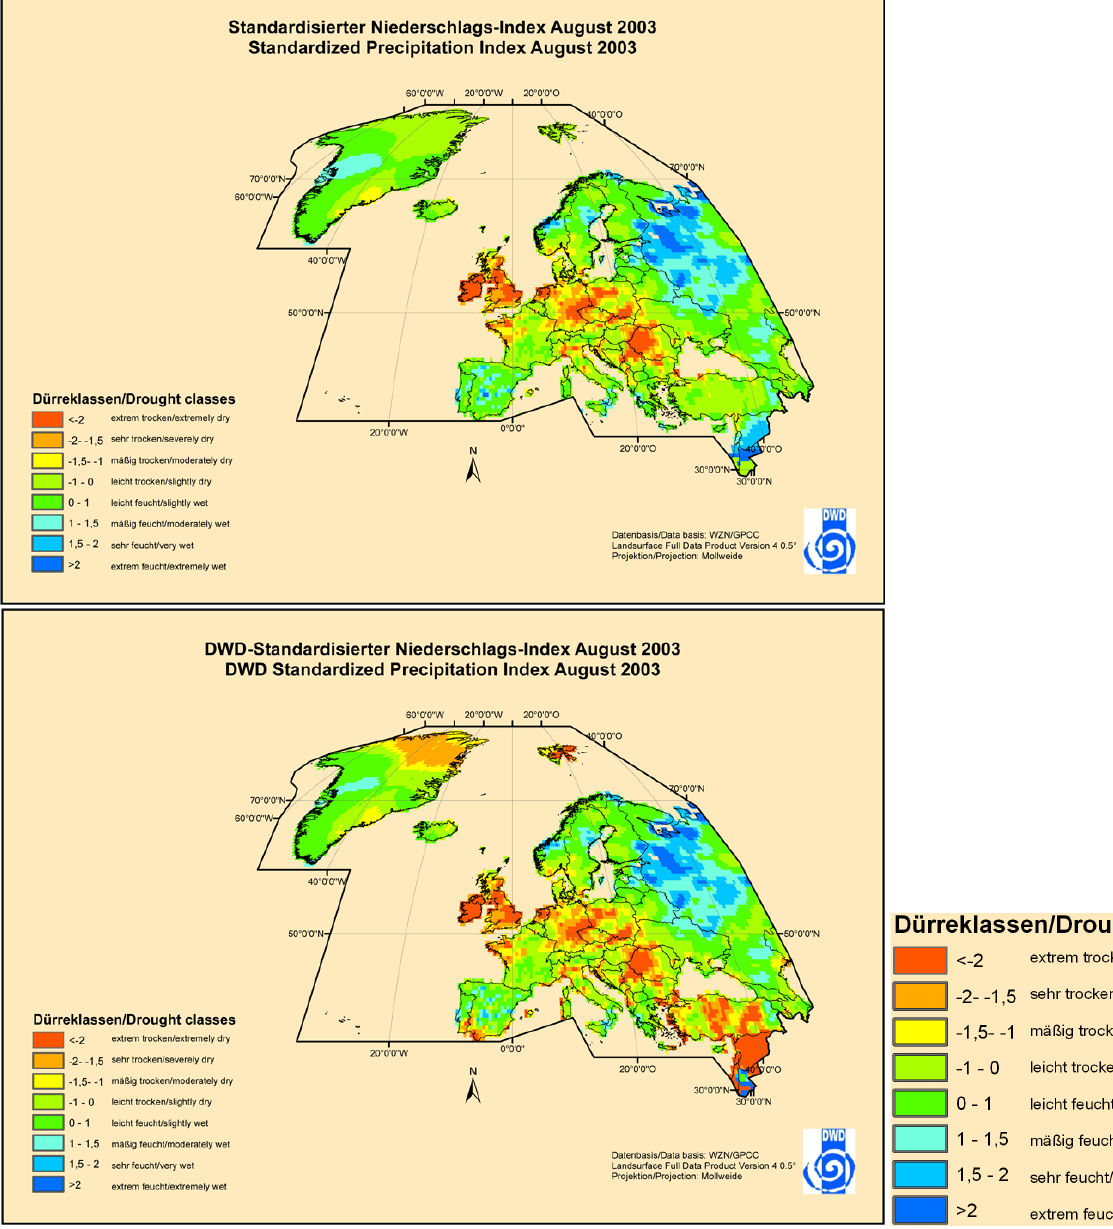
Figure 1. Comparison of the SPI (upper map) and the SPI DWD (lower